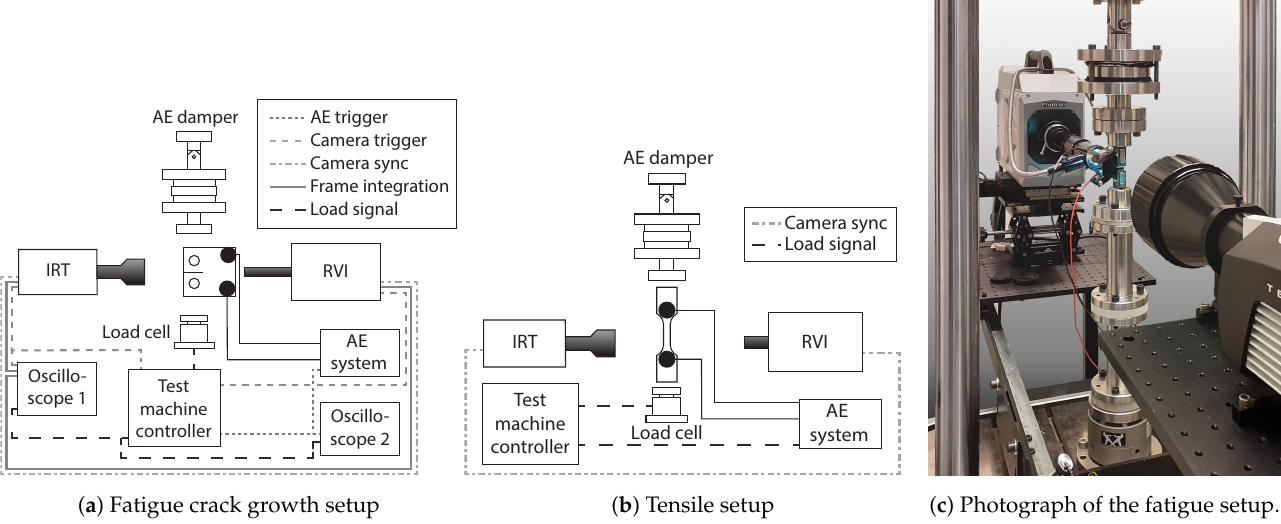
Figure 1. Schematics ( a , b ) and photograph of the setup ( c